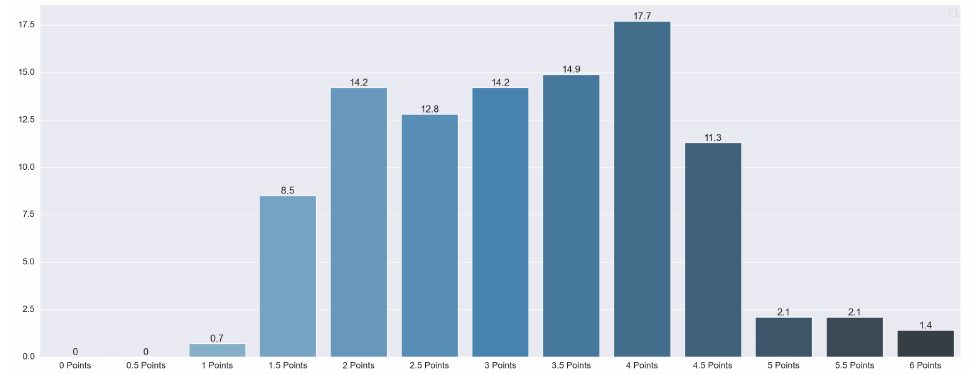
Figure 4. Total quality punctuation of each article. Vertical axis indicates the percentage of articles for a category.